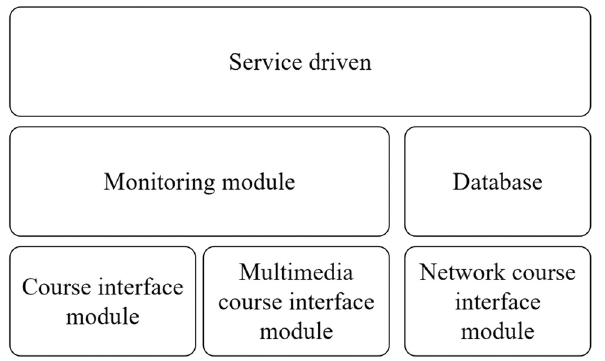
Figure 2: Operating architecture of the system.